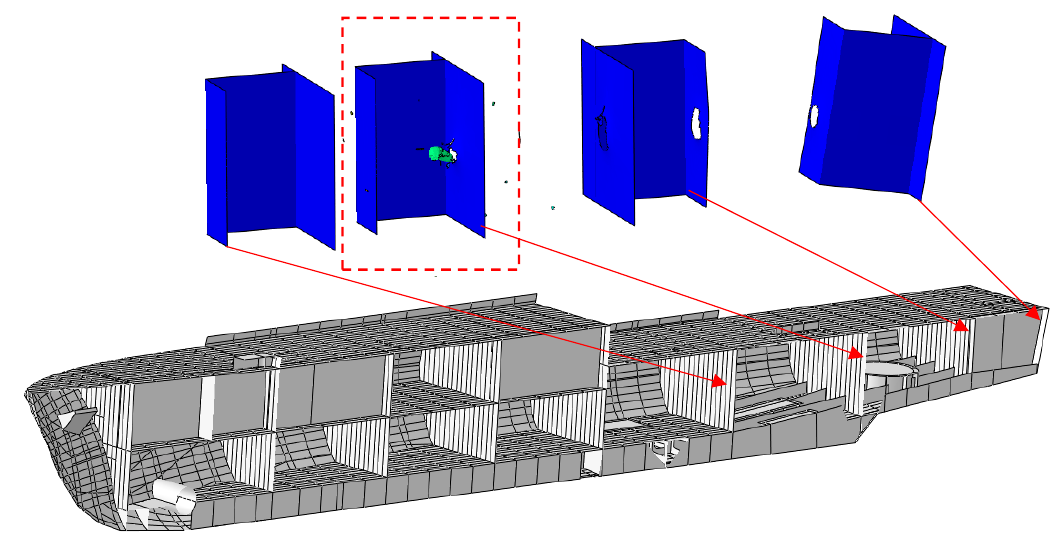
Figure 9. The 2 mm thick hull bullet penetration results.